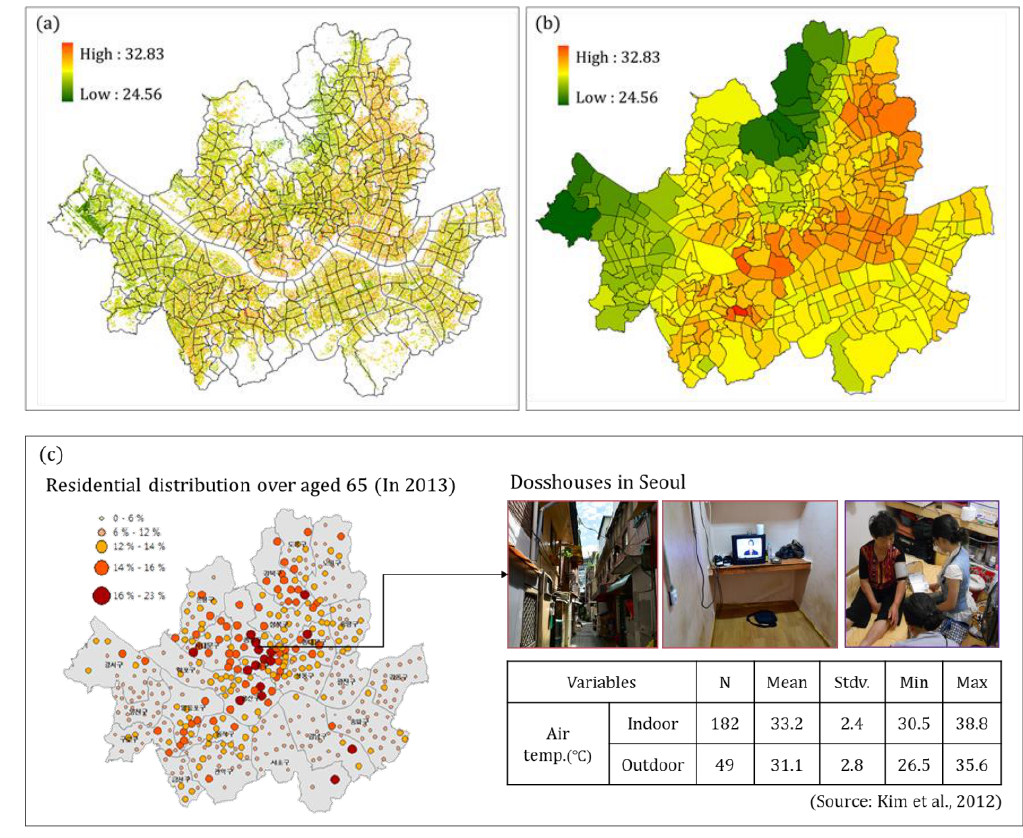
Figure 14. Proposed collaboration framework between local weather service (grid ( a ) and self-government district ( b )) and following self-governance ( c ).